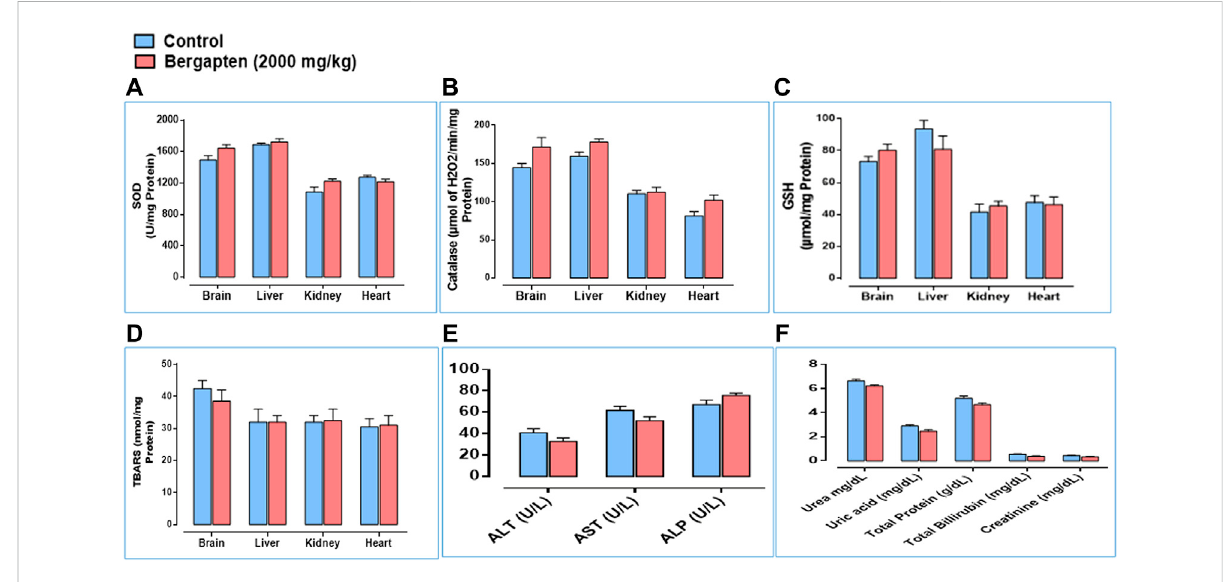
FIGURE 14 Toxicology assay fi ndings showing (A) the expression level of SOD (superoxide dismutase), (B) expression level of catalase, (C) expression level of GSH (glutathione), (D) expression of TBARS (thiobarbituric acid reactive substances), (E) effect on liver function tests such as ALT (alanine transaminase),AST(aspartateaminotransferase),andALP(alaninephosphatase). (F) Renalfunctiontest(RFTs)measuringurea,uricacid,totalprotein, total bilirubin, and creatinine levels in control and bergapten (2000 mg/kg)-treated rats.